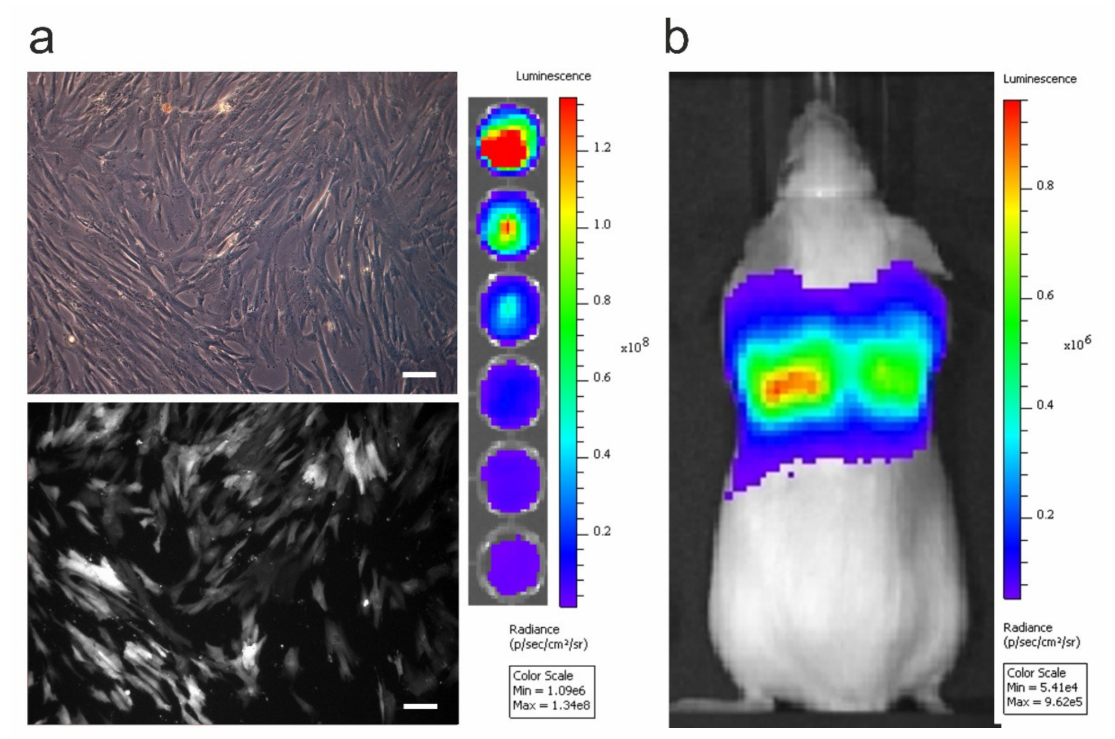
Figure 1. In vitro and in vivo imaging of hUC-MSCs. ( a ) Transmitted (top) and epifluorescence (bottom) images of transfected hUC-MSCs in culture. Scale bar = 100 µ m (left). Representative image of hUC-MSCs seeded at decreasing concentrations (from 2 × 10 4 to 625 cells/well) and treated with 5.12 mM D-Luciferin (right). ( b ) In vivo biodistribution of 2.5 × 10 5 hUC-MSCs 20 min after intravenous